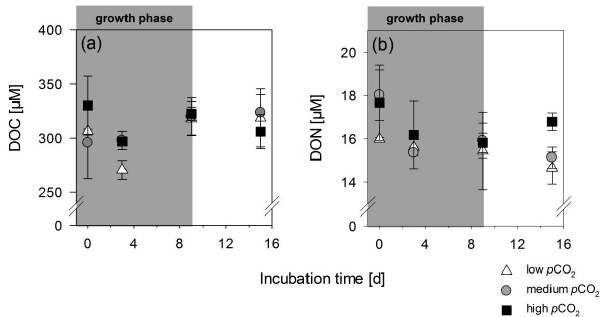
Fig. 3. DON and DOC concentrations over time at low (triangle), medium (circle) and high (squares) p CO 2 . Symbols display the mean of three replicates with standard deviation.